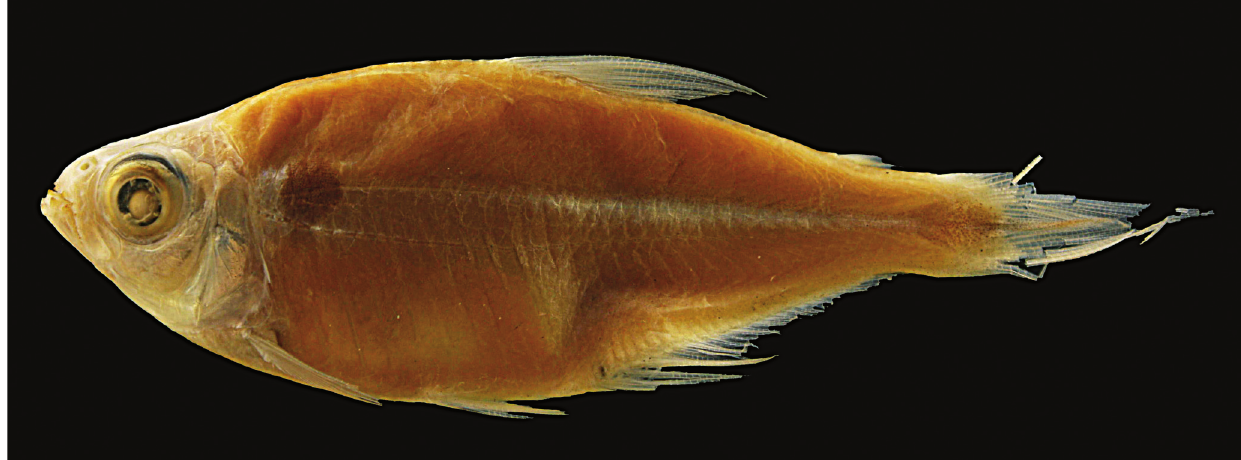
Fig. 3. Probolodus heterostomus , holotype, FMNH 54328, 49.0 mm SL, Brazil, Rio de Janeiro, município de Campos, rio Paraíba do Sul